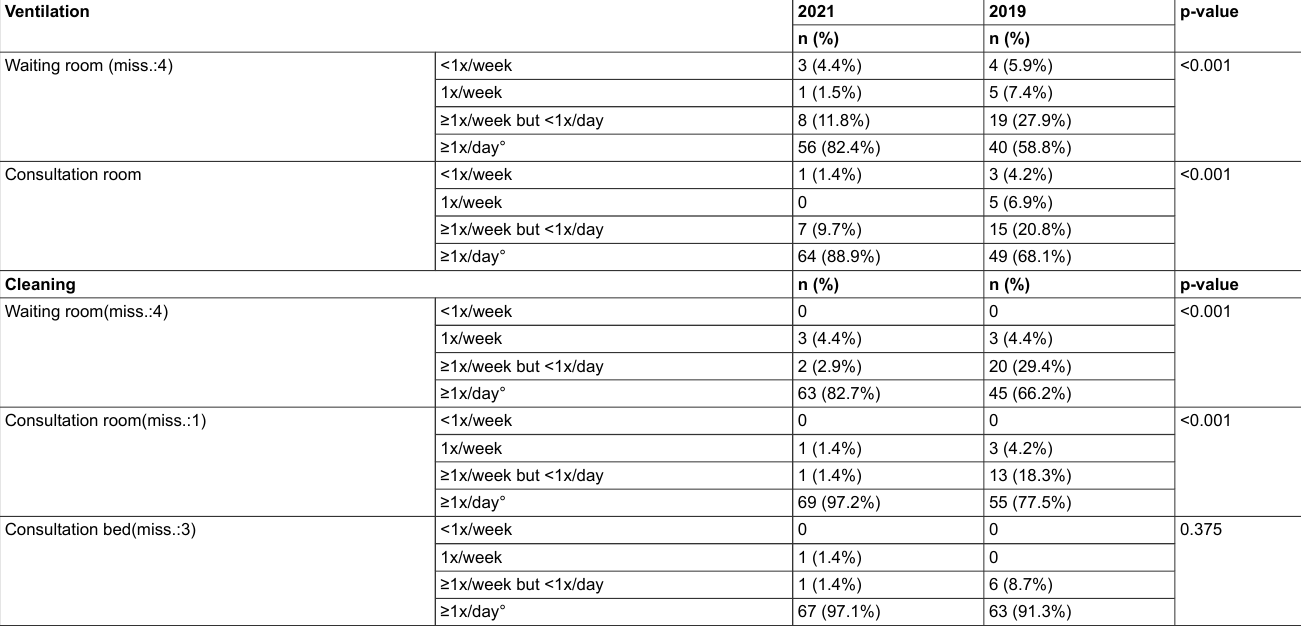
Table S4: Ventilation and cleaning frequency of various areas in the Sentinella network with data for both 2021 and 2019 surveys (72 answering practices). Paired analysis with p-values from exact Mc-Nemar test (proportions) and Wilcoxon signed rank test (counts or ordinal). Ventilation